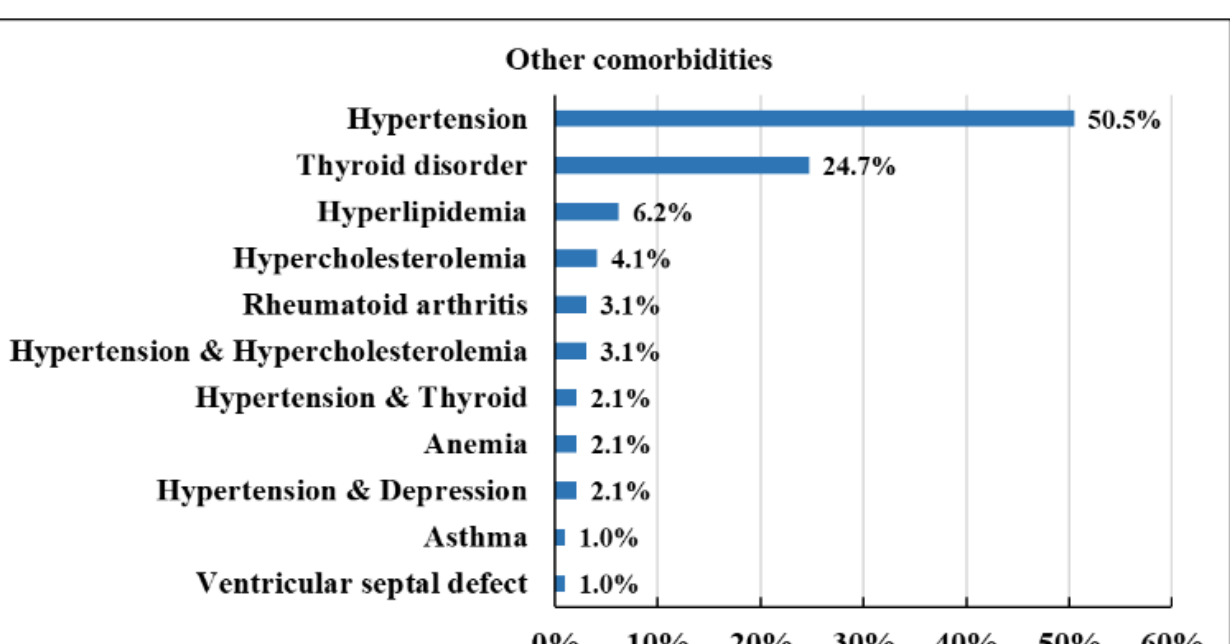
Figure 2. Frequency of other medical conditions among the study participants ( p value = 1.000).